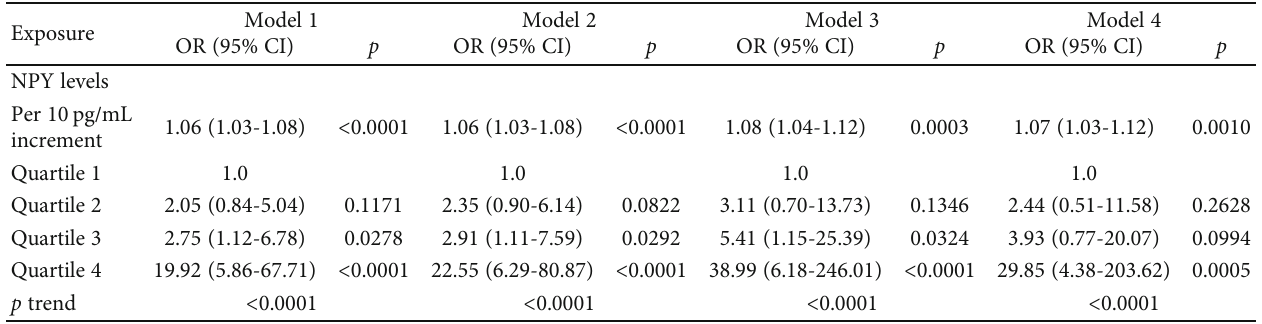
Table 3: Multivariate analysis of the association of serum NPY levels with MUO.